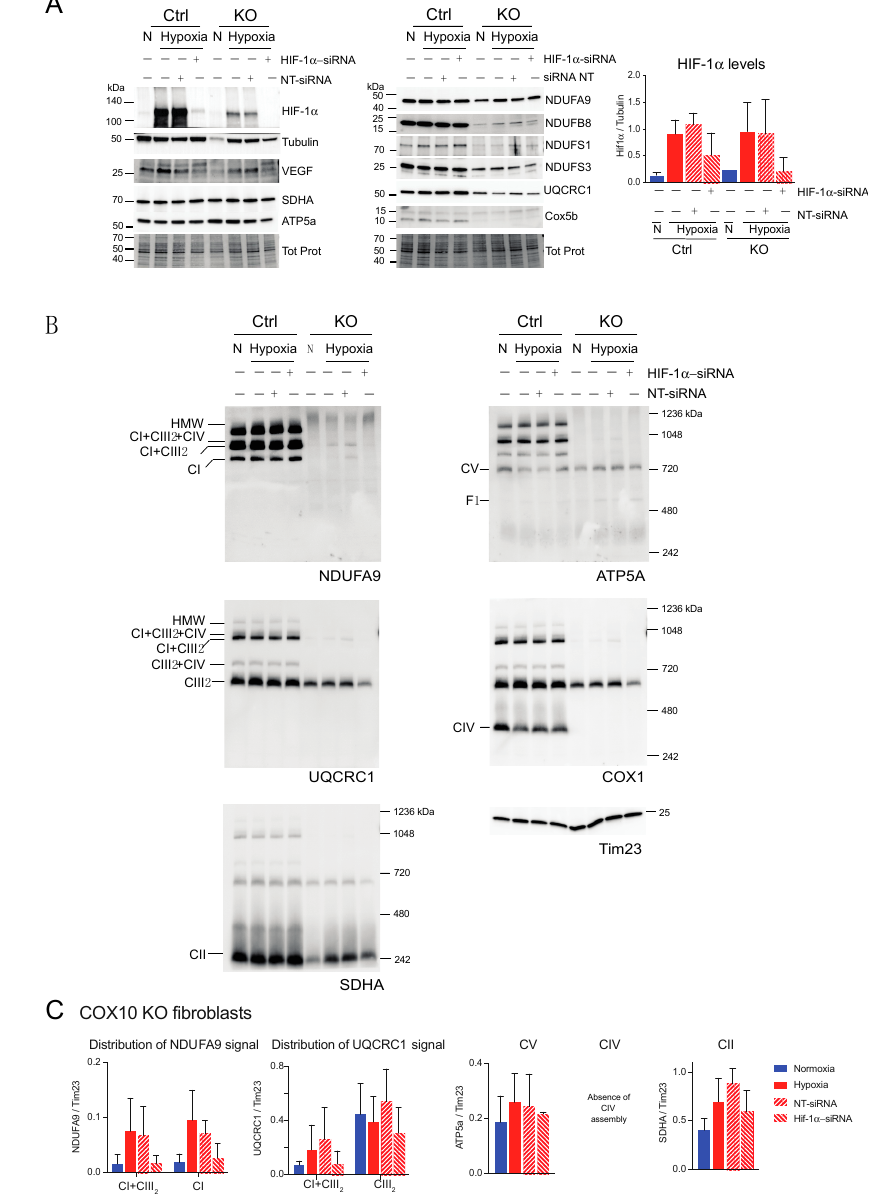
Figure 10. Effect of HIF-1 α siRNA on stability of respiratory complexes in COX10 fibroblasts. COX10 control and KO skin fibroblasts were transfected with either a mixture of oligonucleotides against HIF-1 α (HIF-1 α siRNA) or non-targeted oligos (NT-siRNA) as control. Two rounds of transfection were performed to achieve a robust silencing. ( A ) After 120 h transfection with oligos, cells were exposed to normoxia (N) or hypoxia (H; 1% oxygen) for 24 h and steady-state levels of HIF-1 α , VEGF, and subunits of respiratory complexes SDHA, ATP5a, NDUFA9, NDUFB8, NDUFS1, NDUFS3, UQCRC1 and Cox5b were determined by SDS-PAGE. Loading controls are represented by tubulin